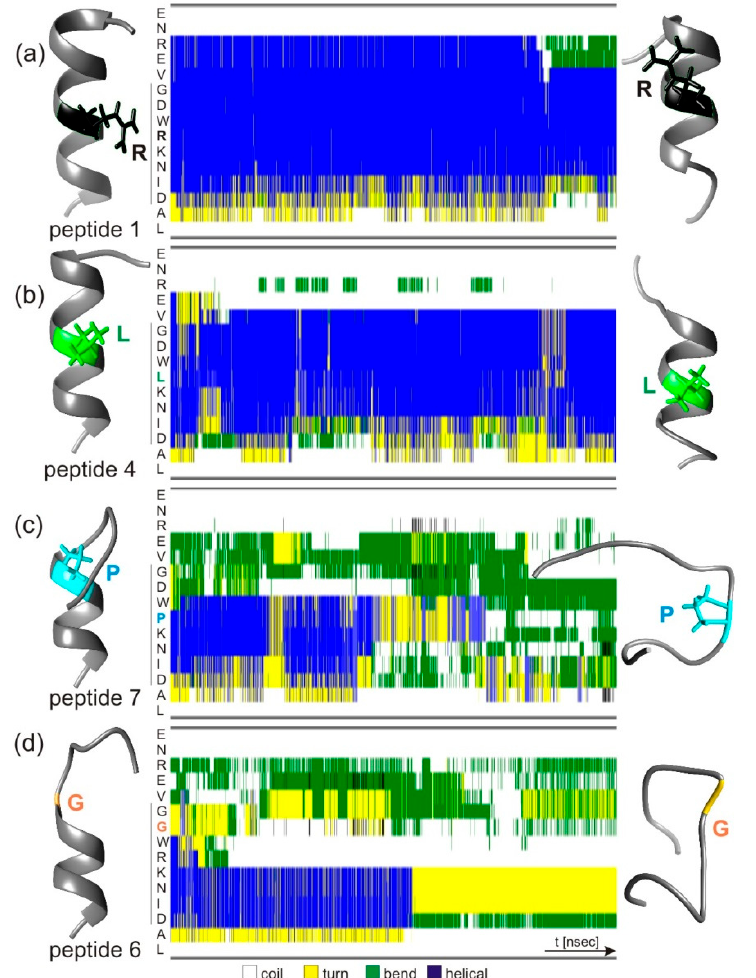
Figure 5. Peptide structure models and secondary structure elements prior to and after molecular dynamics simulations Structure models predicted for epitope peptides (left) were compared to structure models after 50 ns simulations (right). ( a ) peptide 1, ( b ) peptide 4, ( c ) peptide 7, and ( d ) peptide 6. Amino acid residues of peptides are listed from top to bottom (center). The vertical line at the left indicates the epitope region. The secondary structure element in which each residue is involved at a given simulation time point is depicted from left to right as a color-coded bar (10,000 bars per line). Color code: white: coil; yellow: turn; green: bend; blue: helical.